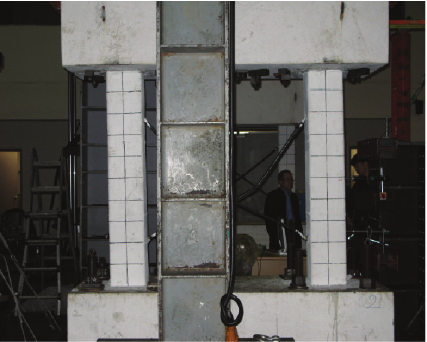
Figure 9: The SF-R1 specimen following cyclic loading tests.